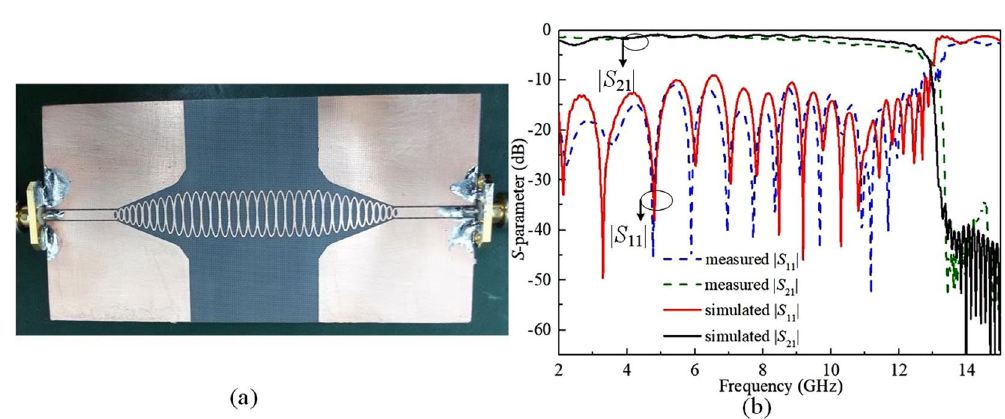
Figure 2. (a ) The photograph of SSPPs waveguide. ( b ) The simulated and measured S -parameter curves of the proposed oval-ring SSPPs waveguide.